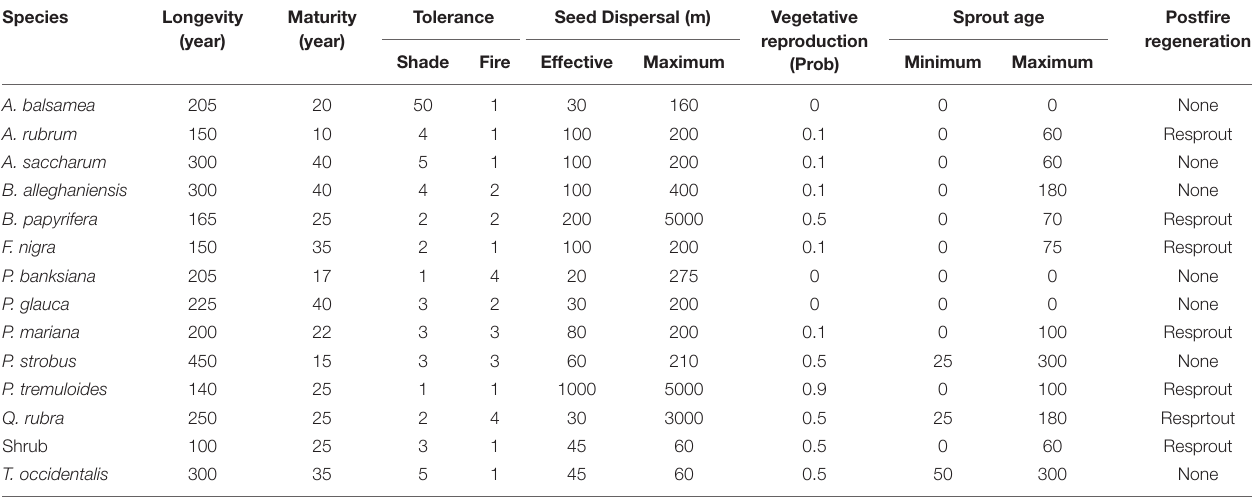
TABLE 1 | Tree species life history parameters used in forest simulation modeling for the species modeled at Isle Royale National Park.